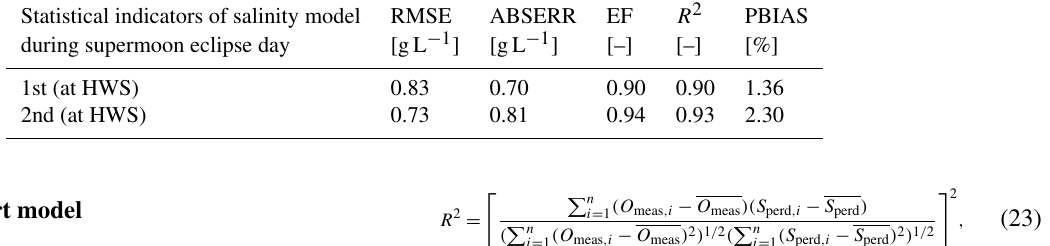
Table 7. Statistical indicators of analytical salinity intrusion model performance at HWS during the supermoon total lunar eclipse day. Statistical indicators of salinity